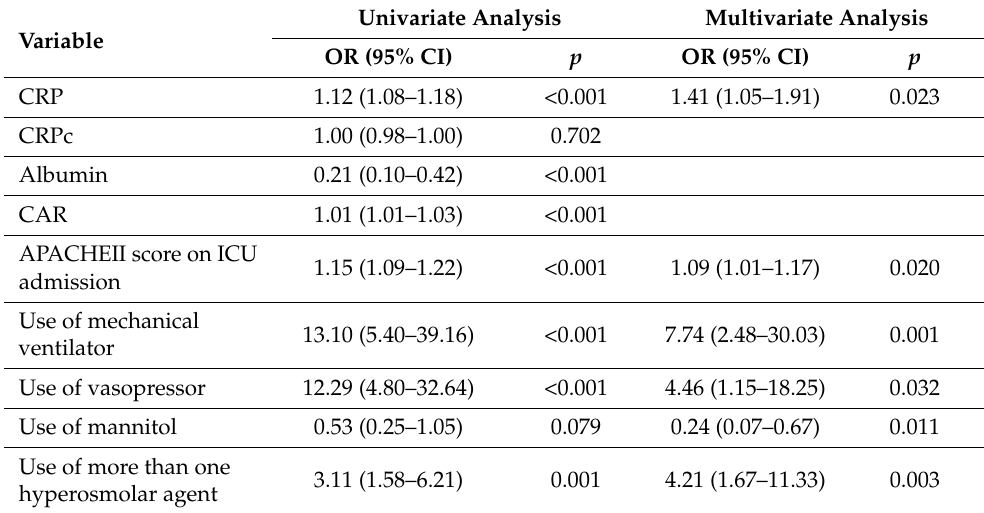
Table 3. Predicting factors for in-hospital mortality in patients assessed using logistic regression